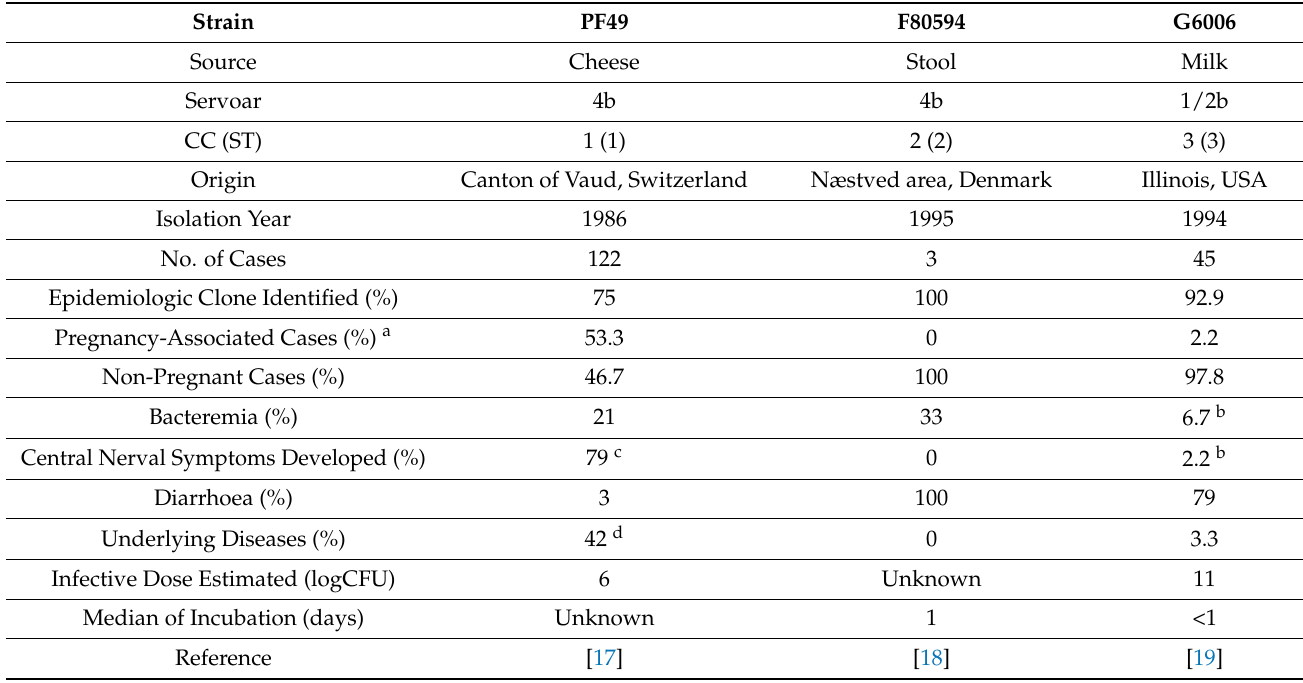
Table 1. Strain information and epidemiological